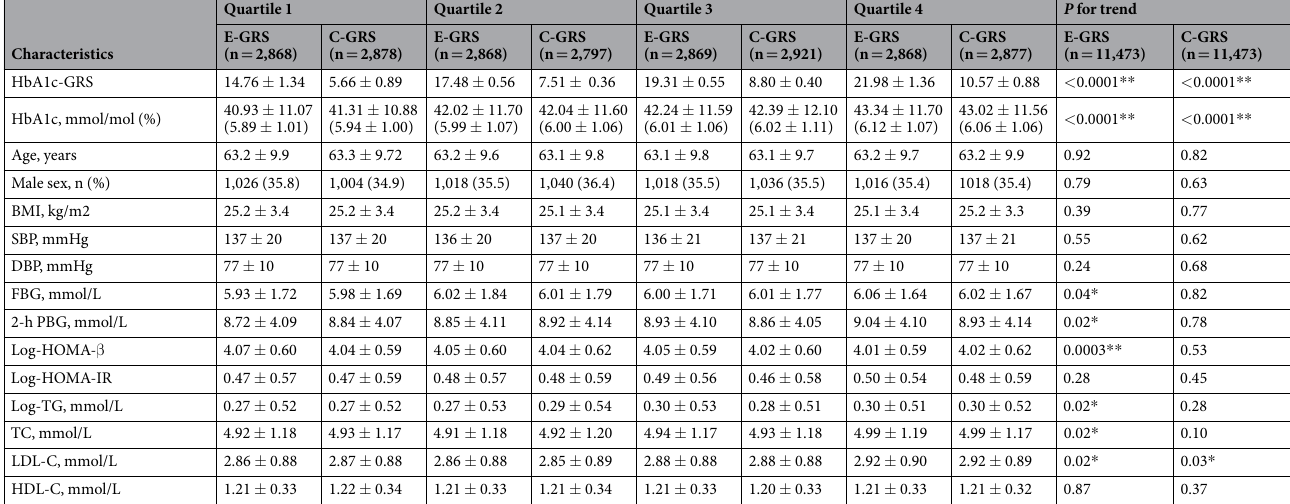
Table 1. Demographic, anthropometry and metabolic traits of the study participants categorized by quartiles of Expanded or Conservative GRS. E-GRS, Expanded genetic risk score, was constructed with the whole 17 SNPs; C-GRS, Conservative genetic risk score, was constructed with 6 Conservative SNPs. SBP, systolic blood pressure; DBP, diastolic blood pressure; FBG, fasting blood glucose; PBG, post-prandial blood glucose;